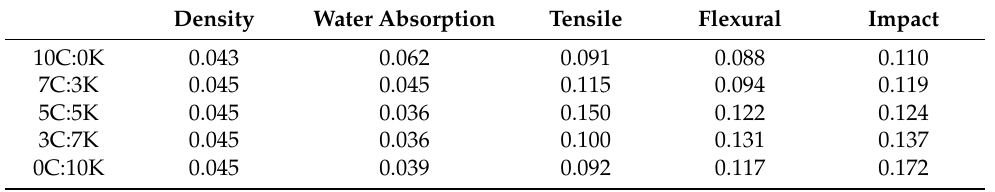
Table 8. The weighted normalized